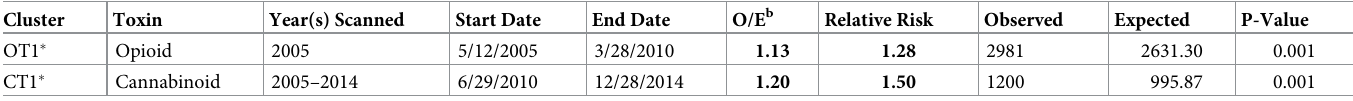
Observed/Expected � No temporal clusters were identified when the analyses were performed by